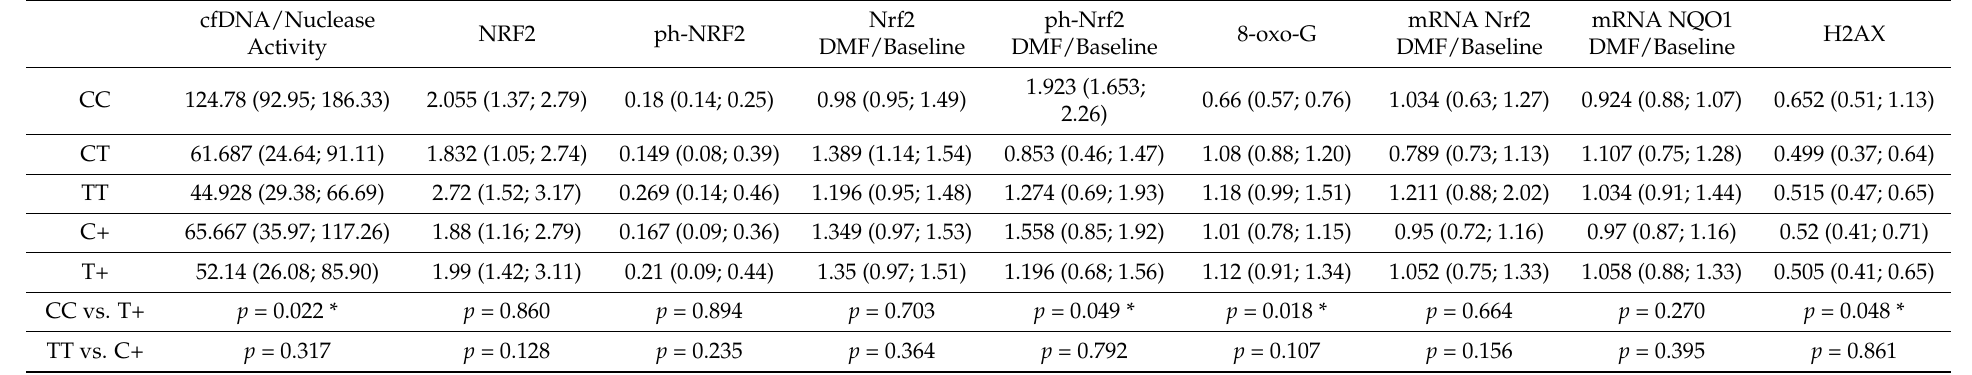
Table 3. Comparison of the content of oxidation/genotoxic stress and adaptive response molecular biomarkers depending on NRF2 genotype and modulation with NRF2 inducer